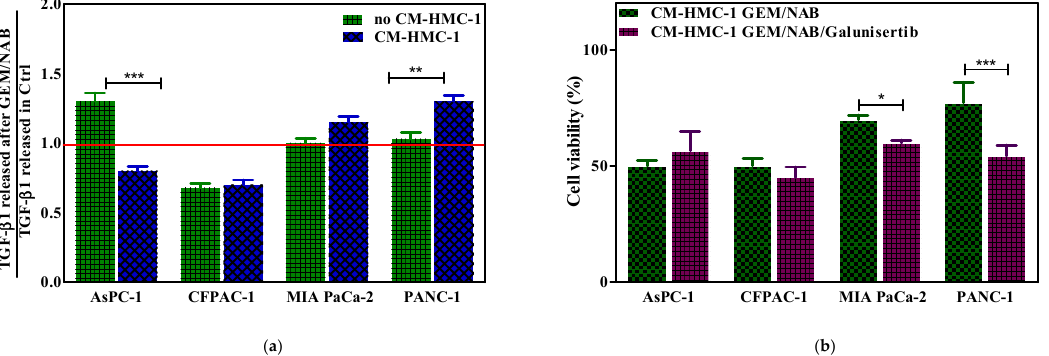
Figure 3. CM-HMC-1 induces the release of TGF- β 1 and resistance to GEM/NAB. The release of TGF- β 1 from cells was assessed after treatment(s). ( a ) Fold change of TGF- β 1 release from GEM/NAB treated cells versus control sample, in presence and absence of CM-HMC-1 (*** p < 0.001). ( b ) Selective inhibition of T β RI by galunisertib restored the sensitivity to GEM/NAB in presence of CM-HMC-1. To assess whether TGF- β pathway drives resistance to GEM/NAB, the cell viability was assayed by adding 10 µ M galunisertib to CM-HMC-1 + GEM/NAB (*** p < 0.001).